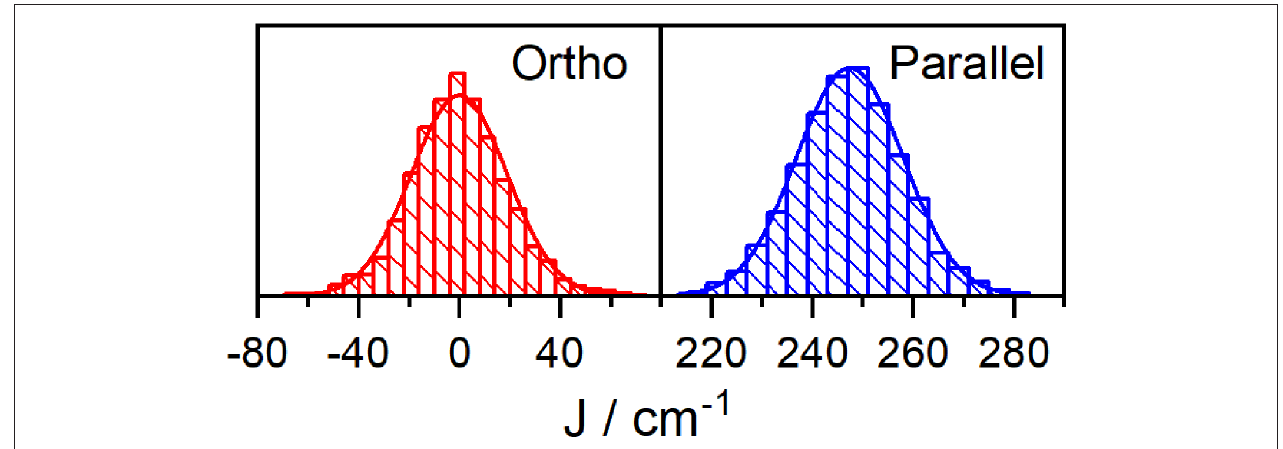
h J 2 i − h J i 2 = 19cm − 1 . (Right) Parallel p